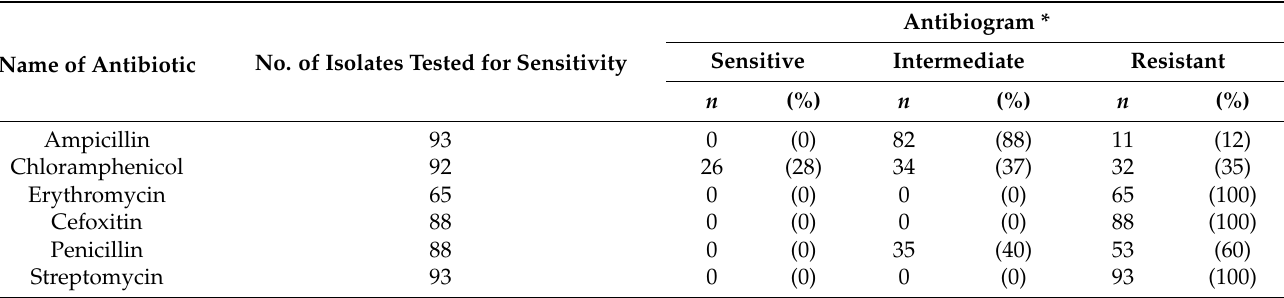
Table 1. Patterns of antibiotic sensitivity for E. coli isolates of poultry excreta in Sierra Leone, 2021 (N = 93).